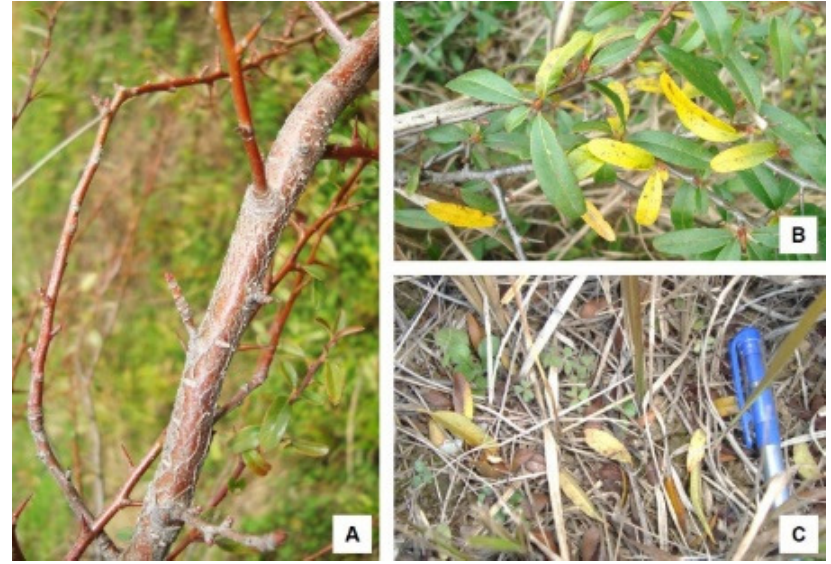
Figure 5. Leaf fall in P. crenulata : (A) leafless twigs observed during March first fortnight, (B) yellow leaves prior to their abscission during February second fortnight, (C) freshly fallen abscised leaves observed under the shrub